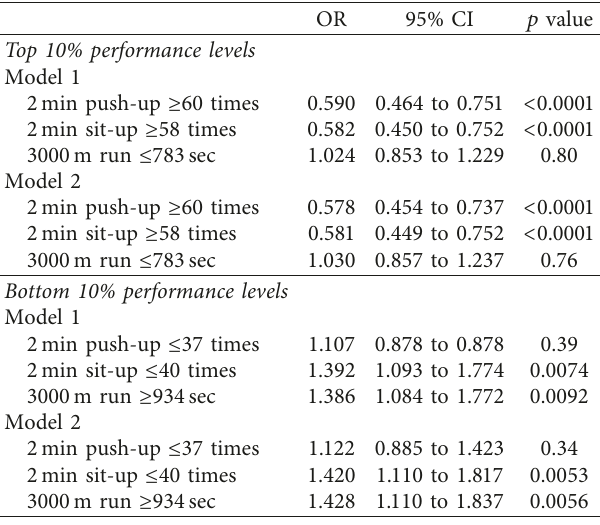
Table 4: Logistic regression models comparing current smokers with noncurrent smokers by the best 10% and the worst 10% exercise performances,